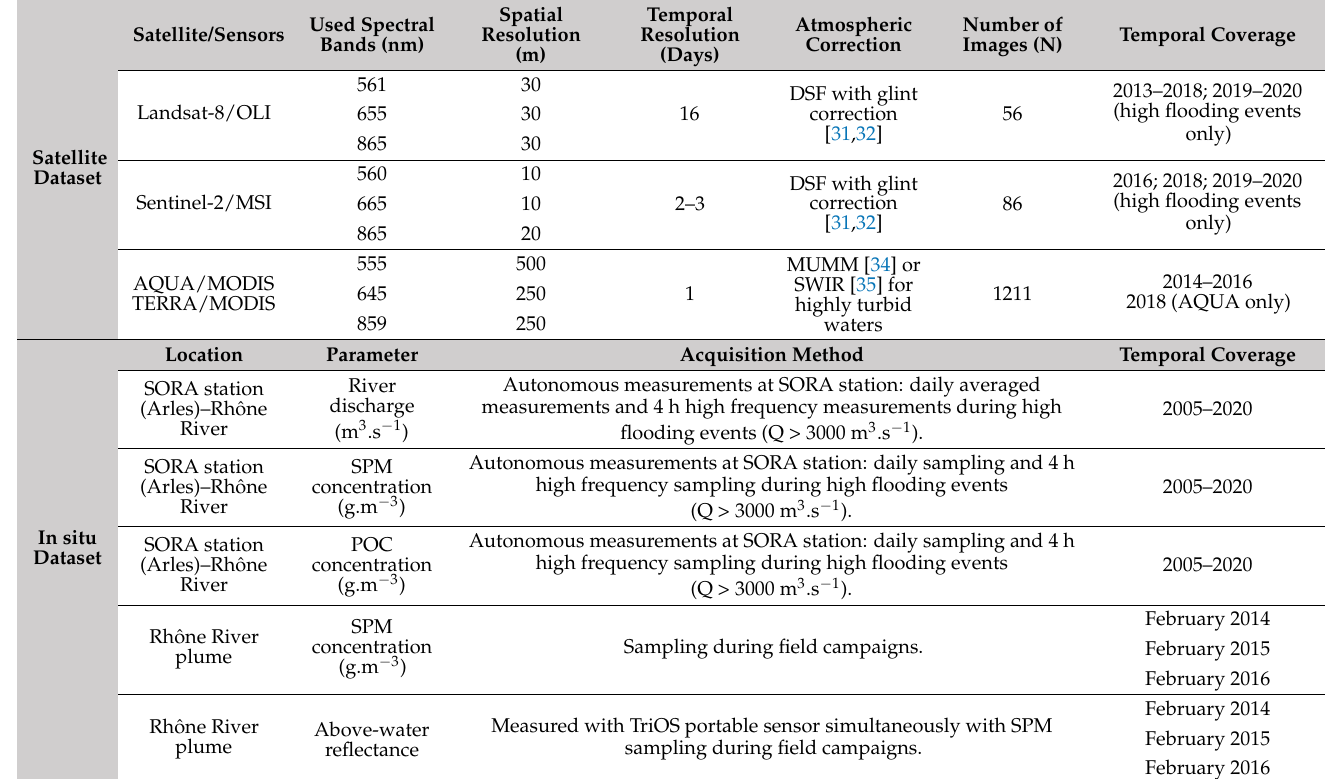
Table 1. In situ and satellite datasets used in this